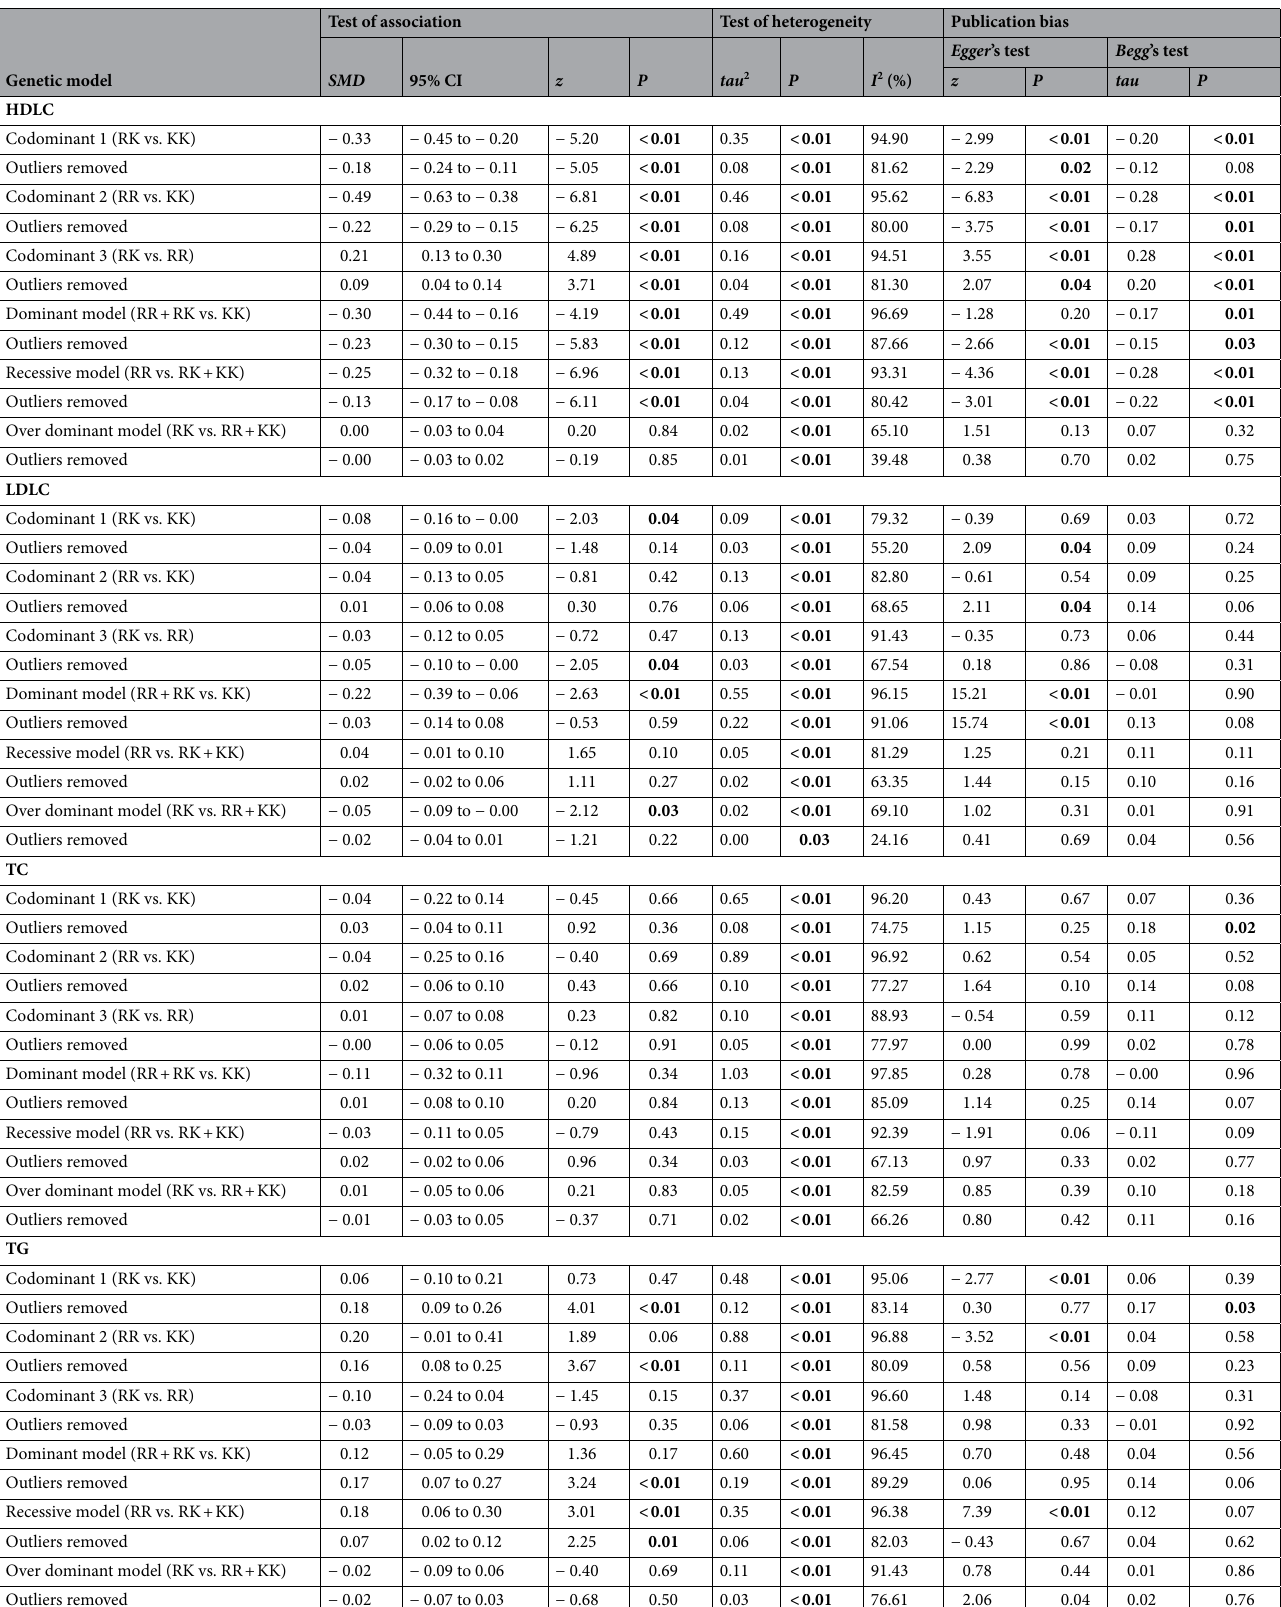
Table 1. Meta-analysis of the association of ABCA1 R219K polymorphism and lipid profiles. SMD: standard mean difference; CI: confidence interval. Bold indicates statistically significant ( P <